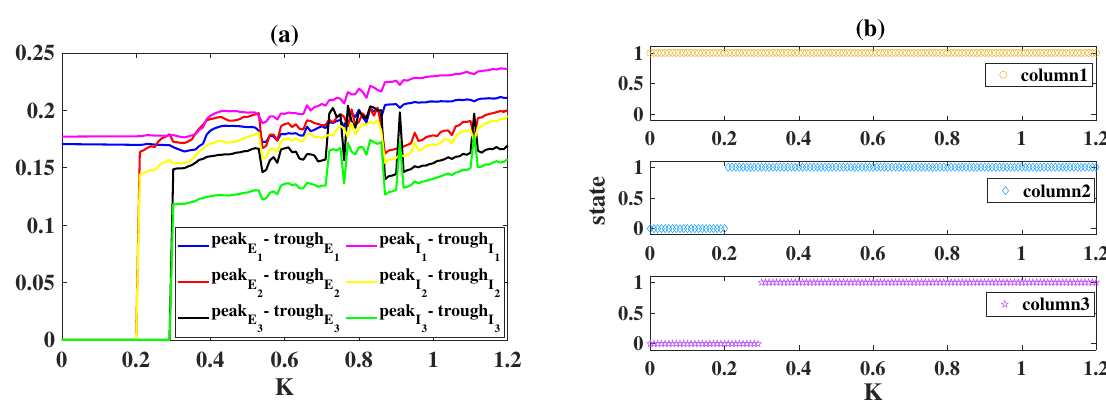
Figure 9. ( a ) Relationship of the extreme value difference with K . ( b ) Relationship of the system’s state with K . When K ≥ 0.2, column2 starts to oscillate, that is, from non-oscillating state 0 to oscillating state 1. Column3 starts to oscillate from K =